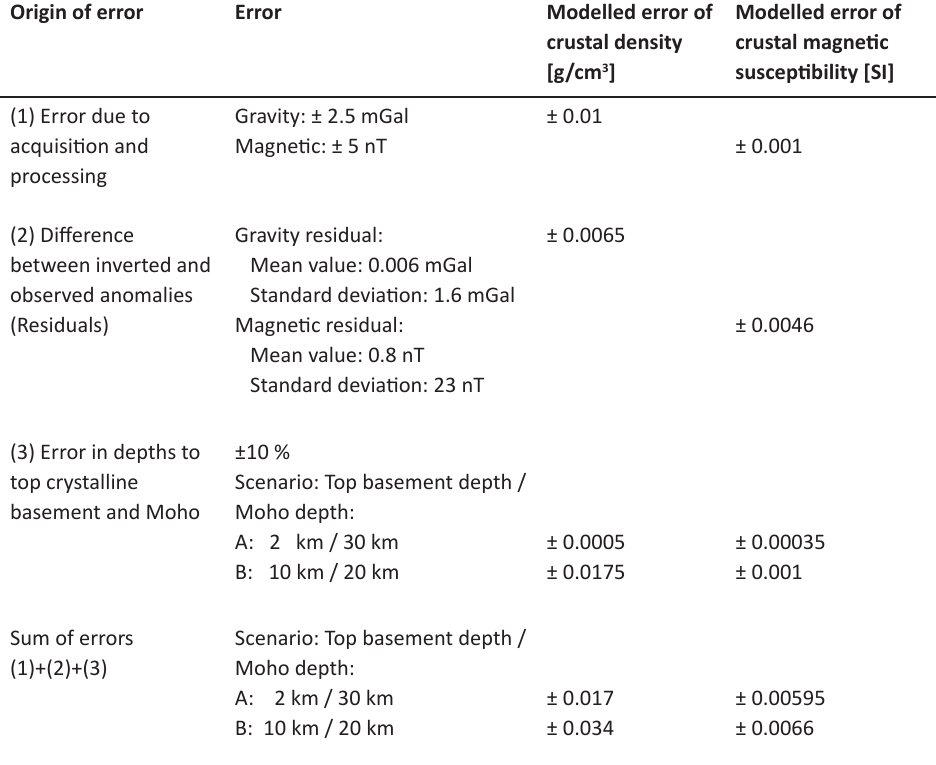
Table 2. Error sources and error estimation of crustal densities and magnetic